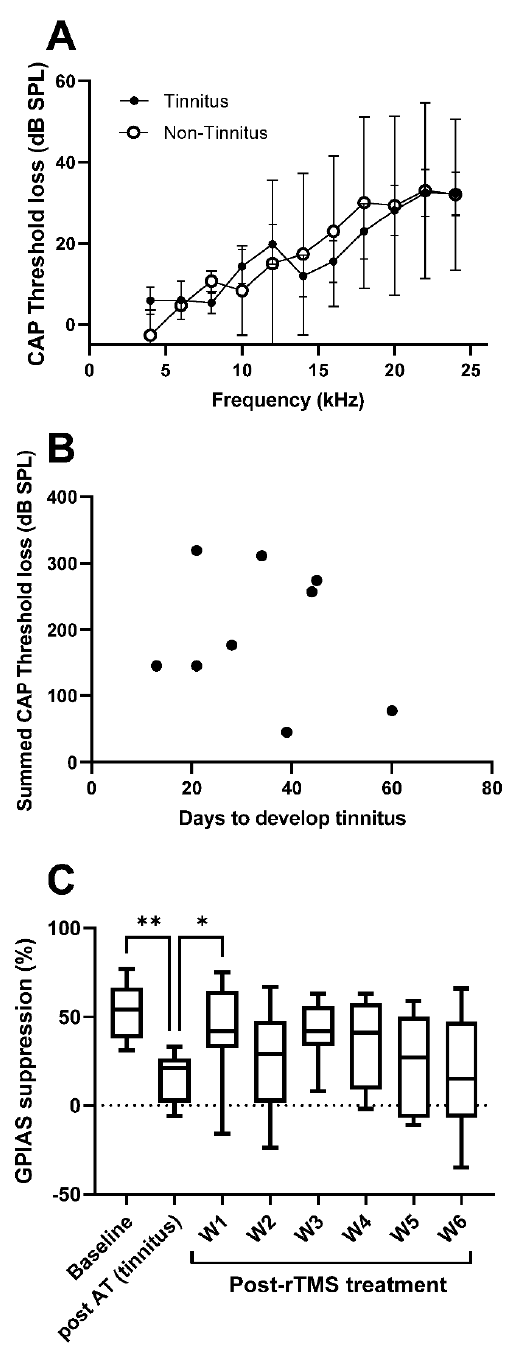
Figure 3. ( A ): Graph showing no difference in CAP thresholds (dB SPL) in tinnitus ( n = 9) and non- tinnitus ( n = 3) animals at EOE. ( B ): Scatterplot showing lack of correlation between CAP threshold loss (summed over all frequencies) and days it took to develop tinnitus in each animal. ( C ): Box and whisker plot of GPIAS suppression (%) before AT (baseline), at the time of tinnitus development (post ‐ AT) and at week 1 to 6 post ‐ treatment. * p < 0.05; ** p < 0.01.